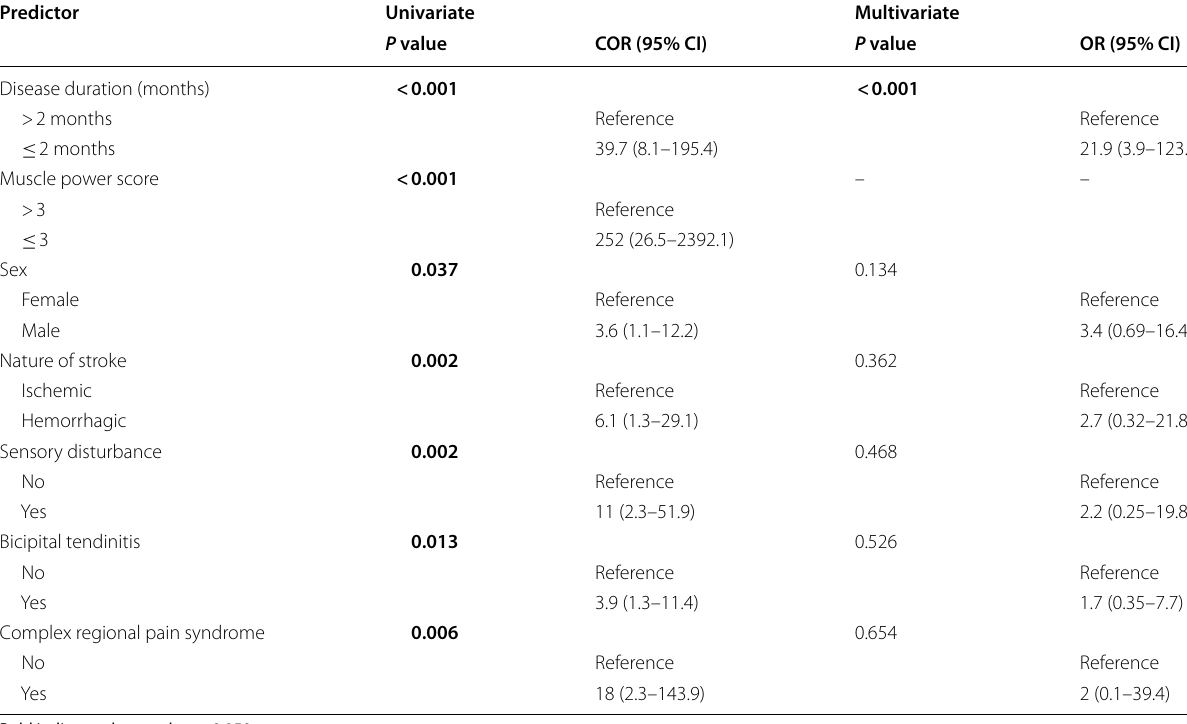
Bold indicates that p value